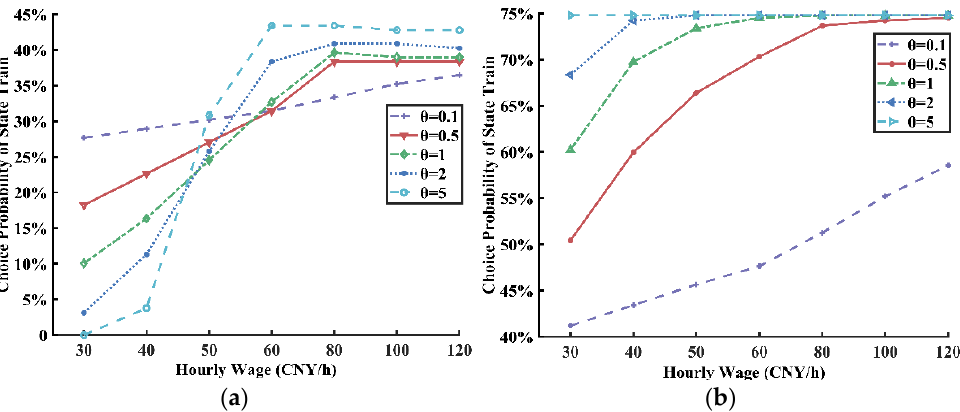
Figure 16. Sensitivity analysis of hourly wages to state train choice probability of suburban passengers at station No. 5. ( a ) Current train No. 7 (Local). ( b ) Current train No. 8 (State).